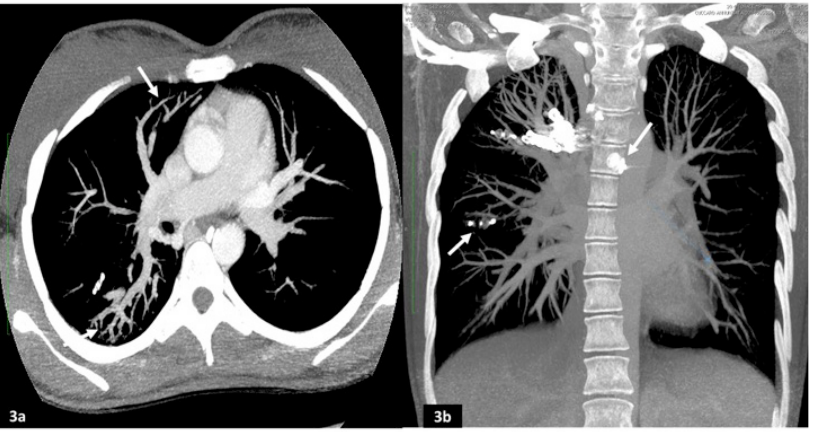
Figure 3: Thoracic angio-CT after embolization. Transversal (a) and Coronal (b)